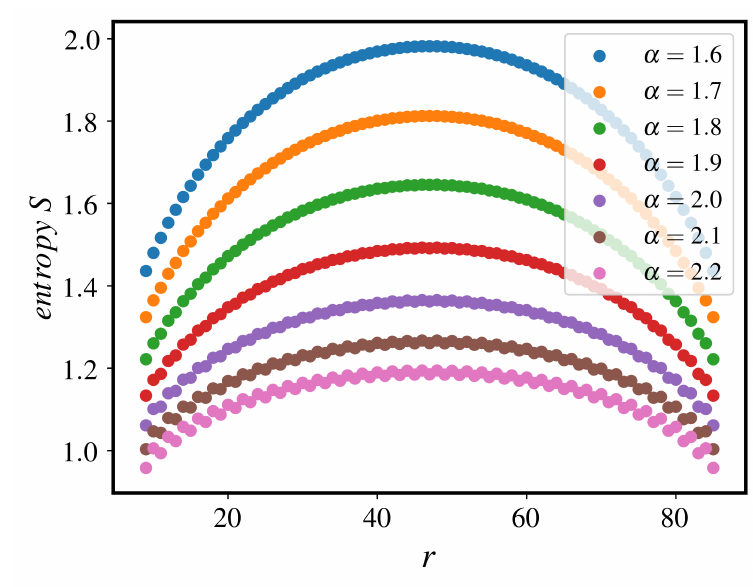
Figure 12: Von Neumann entanglement entropy calculated for a chain with L = 96 sites across the quantum critical